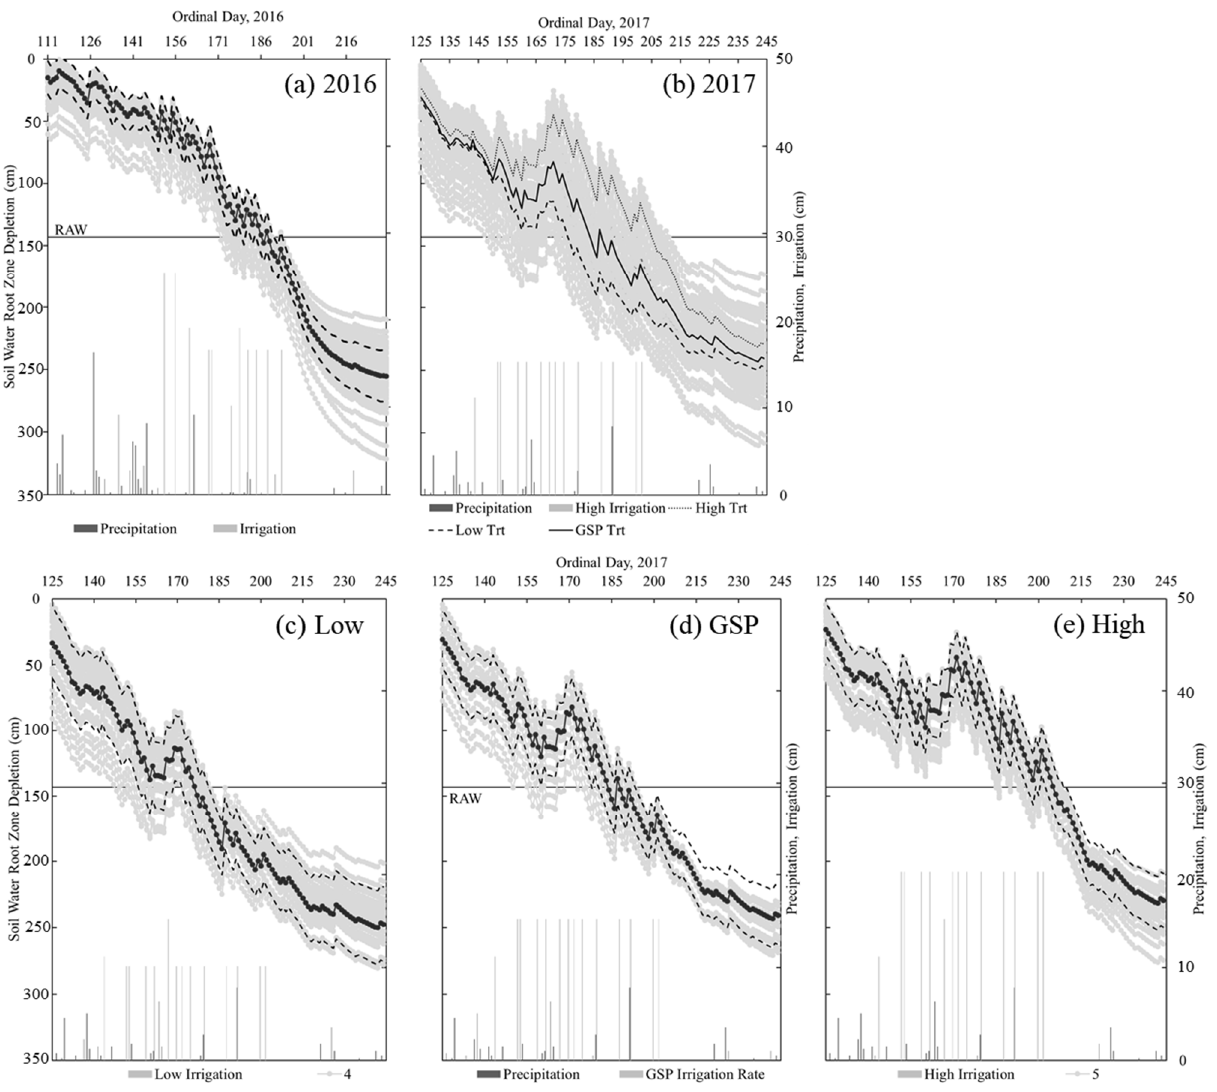
Figure 4. Modelled daily root zone soil water depletion below field capacity in the 1.2 m soil profile for each of the 85 sampling points under ( a ) uniform irrigation or ( b ) spatially variable irrigation treatments. Plots ( c – e ) show spatially variable irrigation separated by low, grower standard practice (GSP), or high irrigation. Solid lines in plots ( c – e ) represent the average for that irrigation rates with dashed lines ± standard deviation.